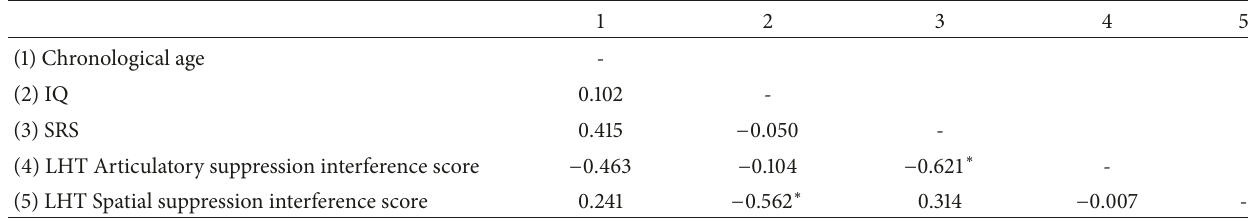
Table 2: Pearson’s correlation between respective